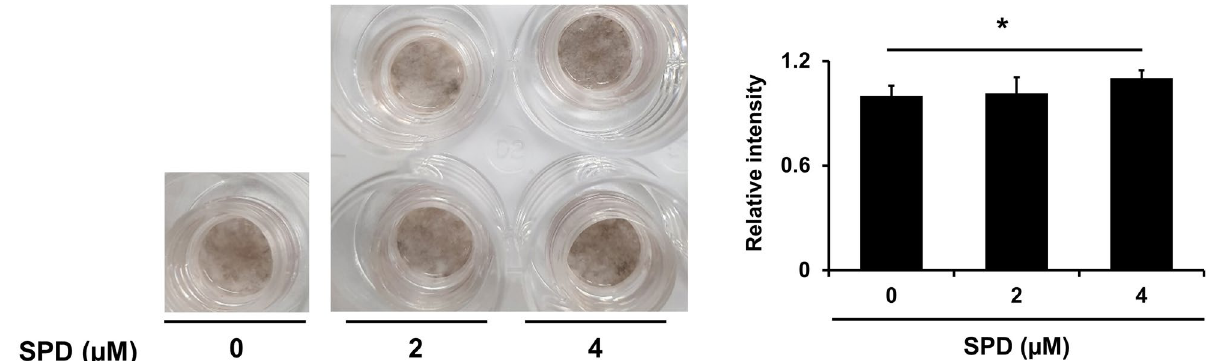
Figure 5. SPD increases melanin production in a human skin equivalent model. Treatment of a human skin equivalent model with 2 and 4 μM of SPD for 2 weeks. The data represent the results of three independent experiments. *P < 0.05 , **P < 0.01 , *** P <